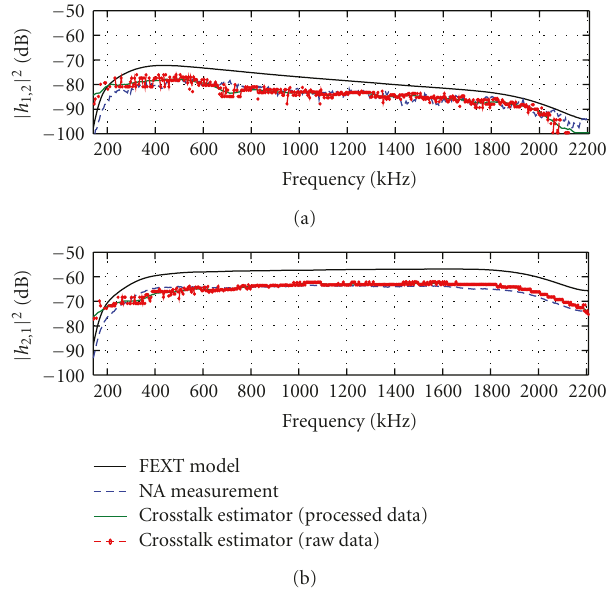
Figure 8: Square-magnitude of the FEXT channels for Scenario I representing: the worst-case FEXT model; the NA measurements; the Crosstalk Estimator estimates in the form of raw data and smoothed curves with the application of an MA